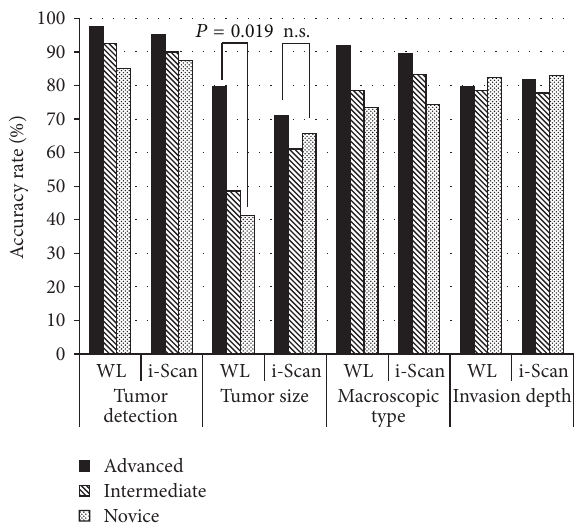
Figure 4: Difference by endoscopist skill level in tumor evaluation from white light (WL) and i-Scan moving